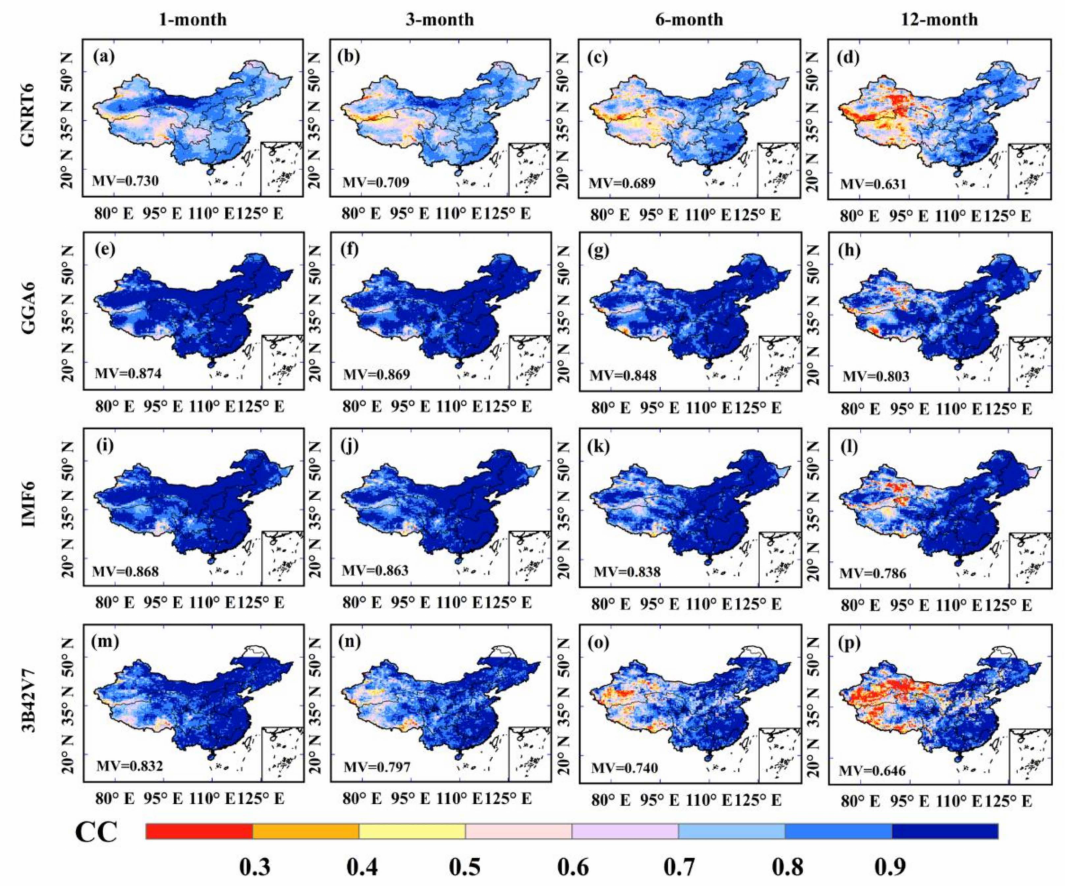
Figure 4. CC of the ( a , e , i , m ) 1-, ( b , f , j , n ) 3-, ( c , g , k , o ) 6- and ( d , h , l , p ) 12-month SPEI based on the four SREs w.r.t in situ observations in June 2000–May 2019. Columns for different time scales, rows for different